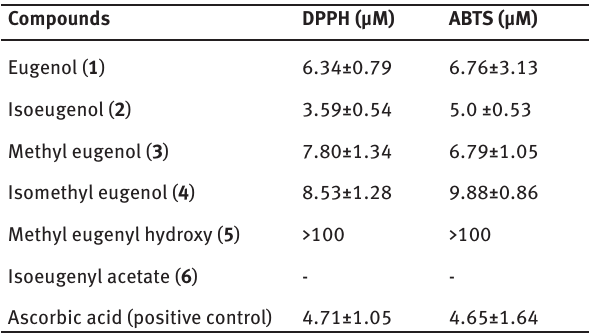
Figure 2 : Inhibition of eugenol and it’s derivatives at DPPH and ABTS. Values were performed in triplicate and represented as mean ± SD. Abbreviation: AA, ascorbic acid. Table 2: Radical scavenging activity of eugenol and it’s